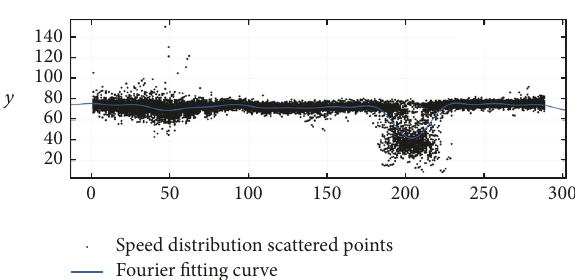
Figure 4: Speed distribution scattered points and Fourier fitting